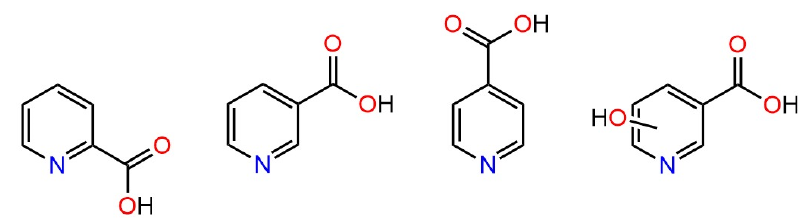
Figure 1. Molecular structures of picolinic, nicotinic, and hydroxynicotinic acids.